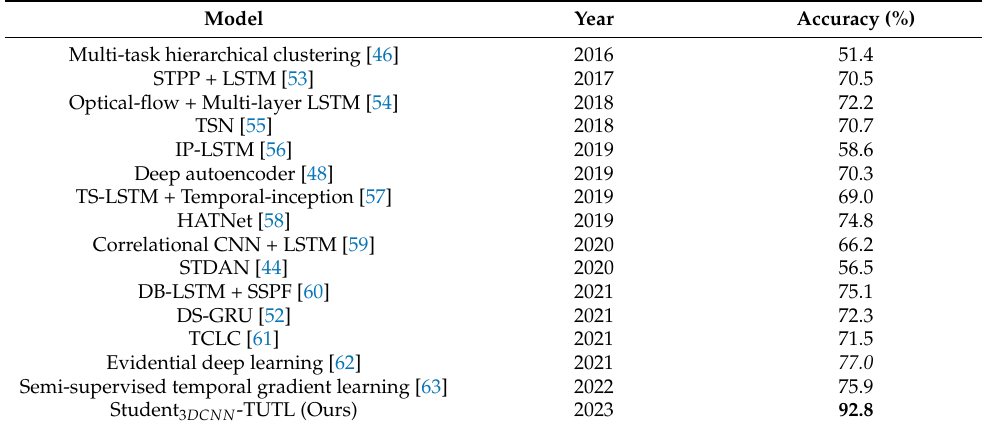
Table 8. Quantitative comparative analysis of our proposed method with the state-of-the-art action recognition methods on HMDB51 dataset.